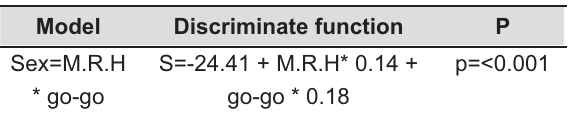
Legend: go-go=Bigonial diameter; M.R.H.D=Ramus height right; M.R.H.E= Ramus height left height right; M.R.H.E=Ramus height left Northeast region Southeast region